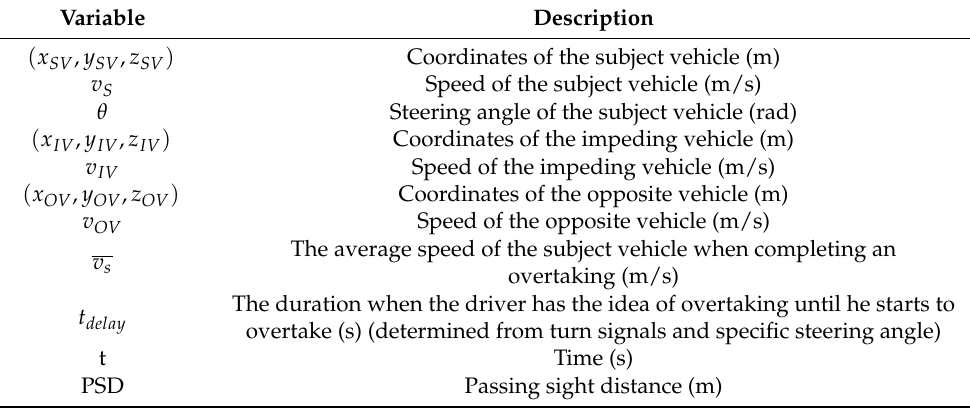
Table 2. Description of